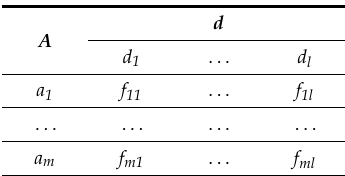
Table 8. Contingency table M .